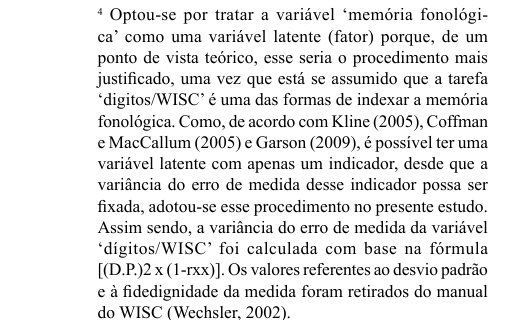
Como pode ser observado na Figura 3, os resultados relativos à avaliação desse terceiro modelo